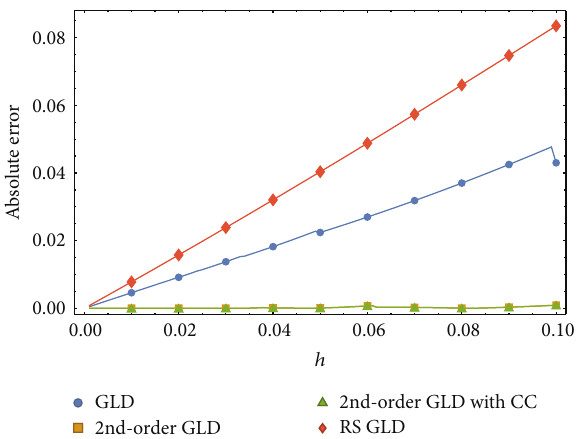
Figure 2: Absolute error over varying values of Δ𝑡 for four different methods.